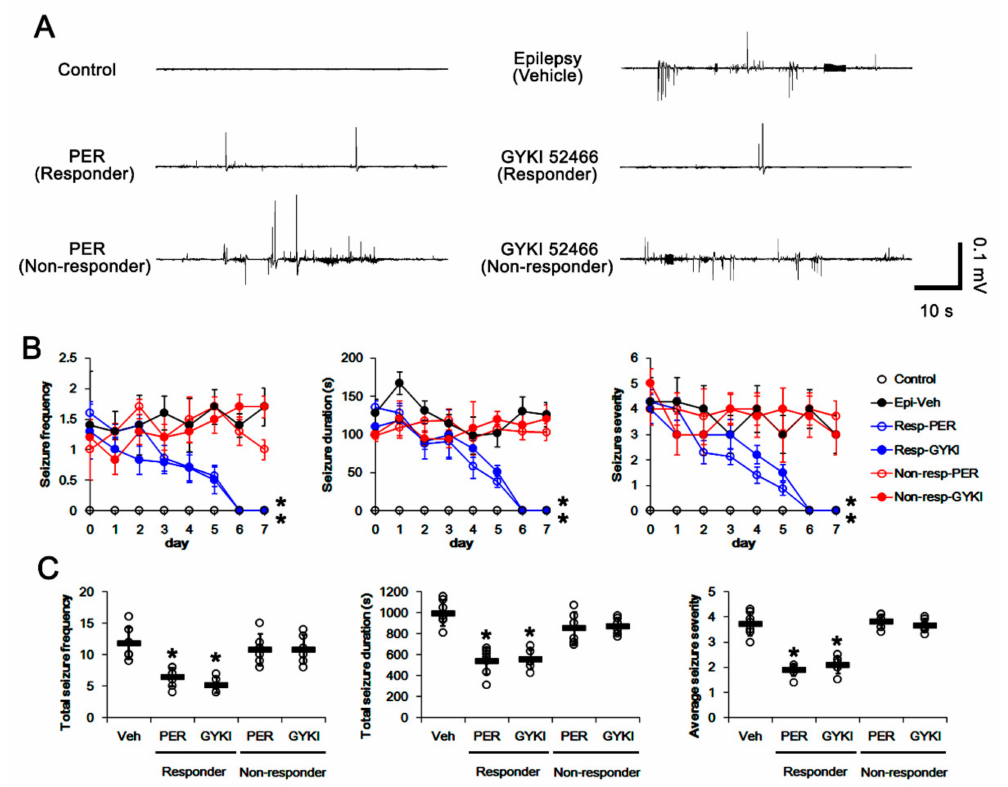
Figure 2. The effects of perampanel (PER) and GYKI 52466 (GYKI) on spontaneous seizure activities in chronic epilepsy rats. Both α -amino-3-hydroxy-5-methylisoxazole-4-propionic acid receptor (AMPAR) antagonists effectively attenuate spontaneous seizure activities in responders. ( A ) Representative electroencephalograms (EEG) in each group at 2 days after treatment. ( B ) Quantitative analyses of the chronological effects of AMPAR antagonists on seizure frequency, seizure duration, and seizure severity (seizure score) over 7-day period. Error bars indicate SD ( * p < 0.05 vs. vehicle (Veh)-treated animals; Friedman test for seizure frequency and seizure severity; Repeated measures ANOVA for seizure duration). ( C ) Quantitative analyses of seizure frequency, total seizure duration and average behavioral seizure score (seizure severity) in 7-day period. Open circles indicate each individual value. Horizontal bars indicate mean value. Error bars indicate SD ( * p < 0.05 vs. vehicle (Veh)-treated animals; Mann–Whitney U-test for seizure frequency and seizure severity; Student t -test for seizure